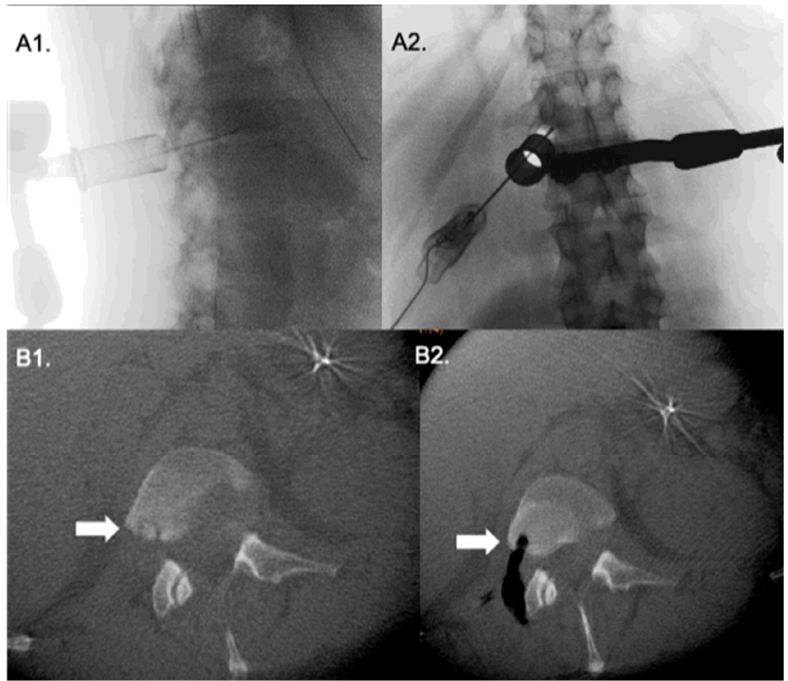
Figure 2. Transforaminal approach to to a tumor in the posterior aspect of L1 vertebral body. Lateral and antero-posterior fluoroscopy ( A1 , A2 ) show the tubular retractor with a probe pointing to the lesion site. Intraoperative O-arm CT axial cuts ( B1 , B2 ) before and after tumor resection.